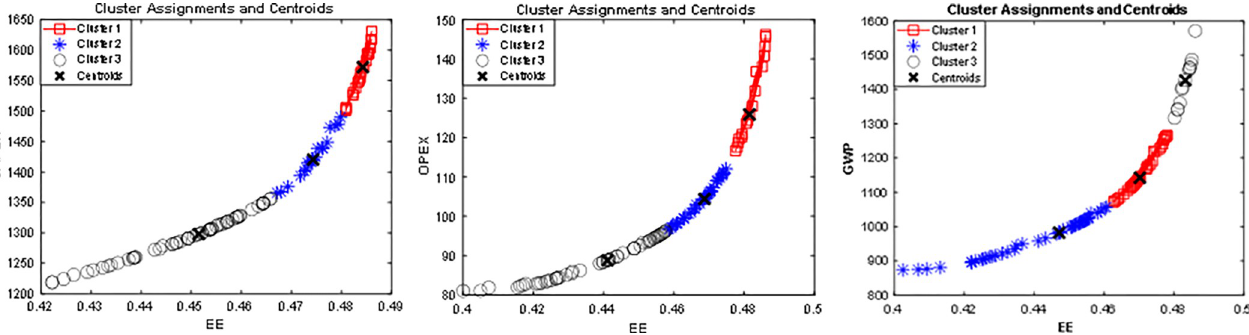
PLOS ONE | https://doi.org/10.1371/journal.pone.0272160 February 3,